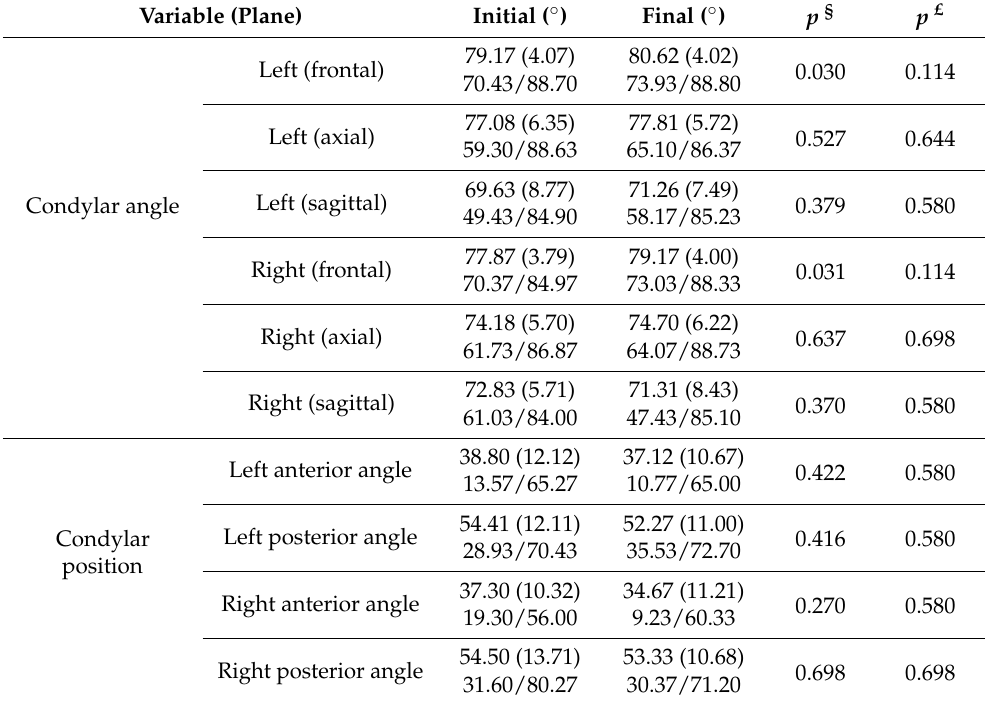
Table 2. Condylar angle and position before and after maxillary expansion. The values are presented in the following order: mean (standard deviation)